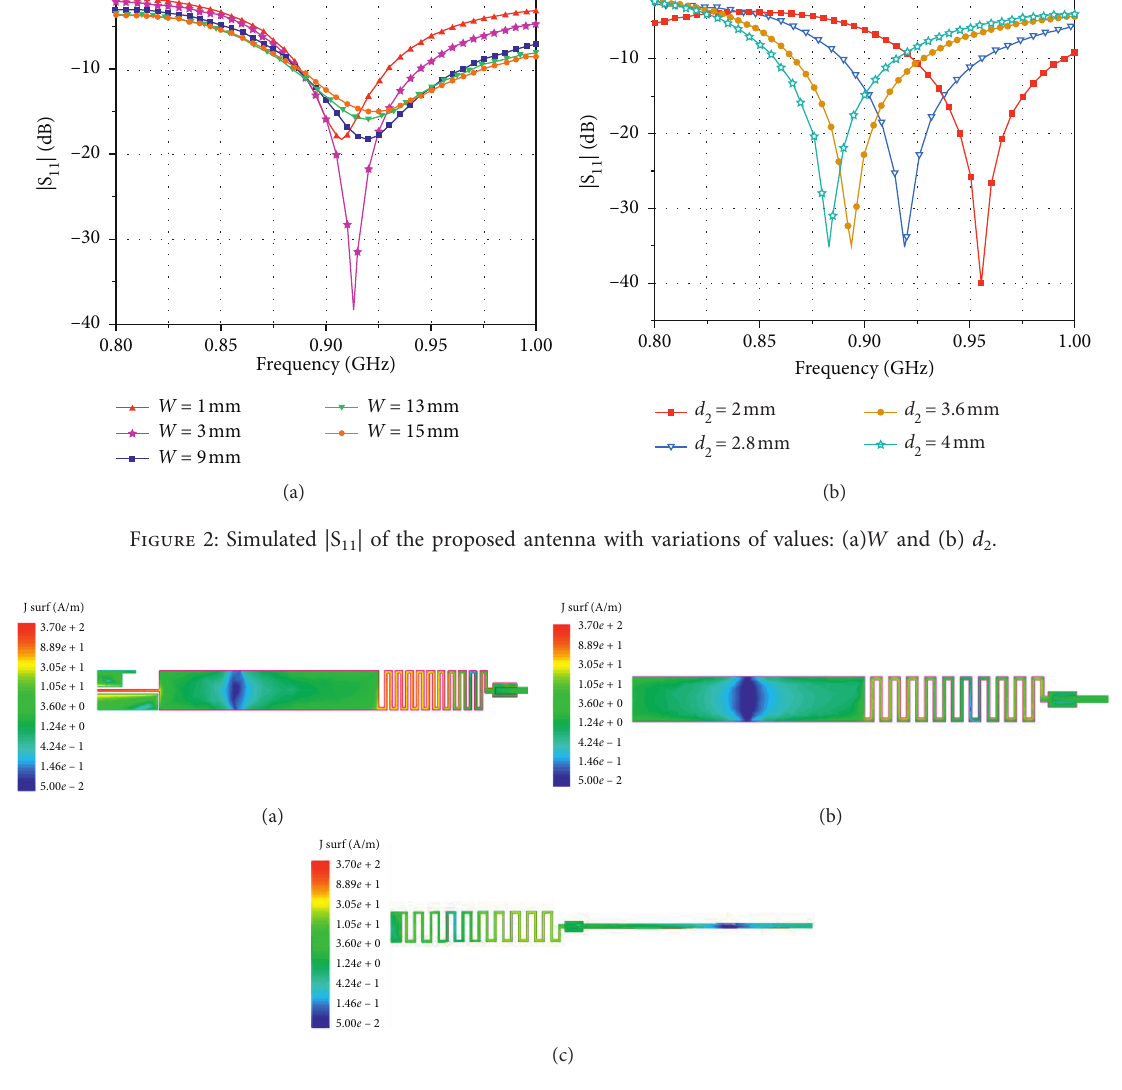
� 1 mm, (b) d � 2mm, and (c) d � 3mm. 2 2 2